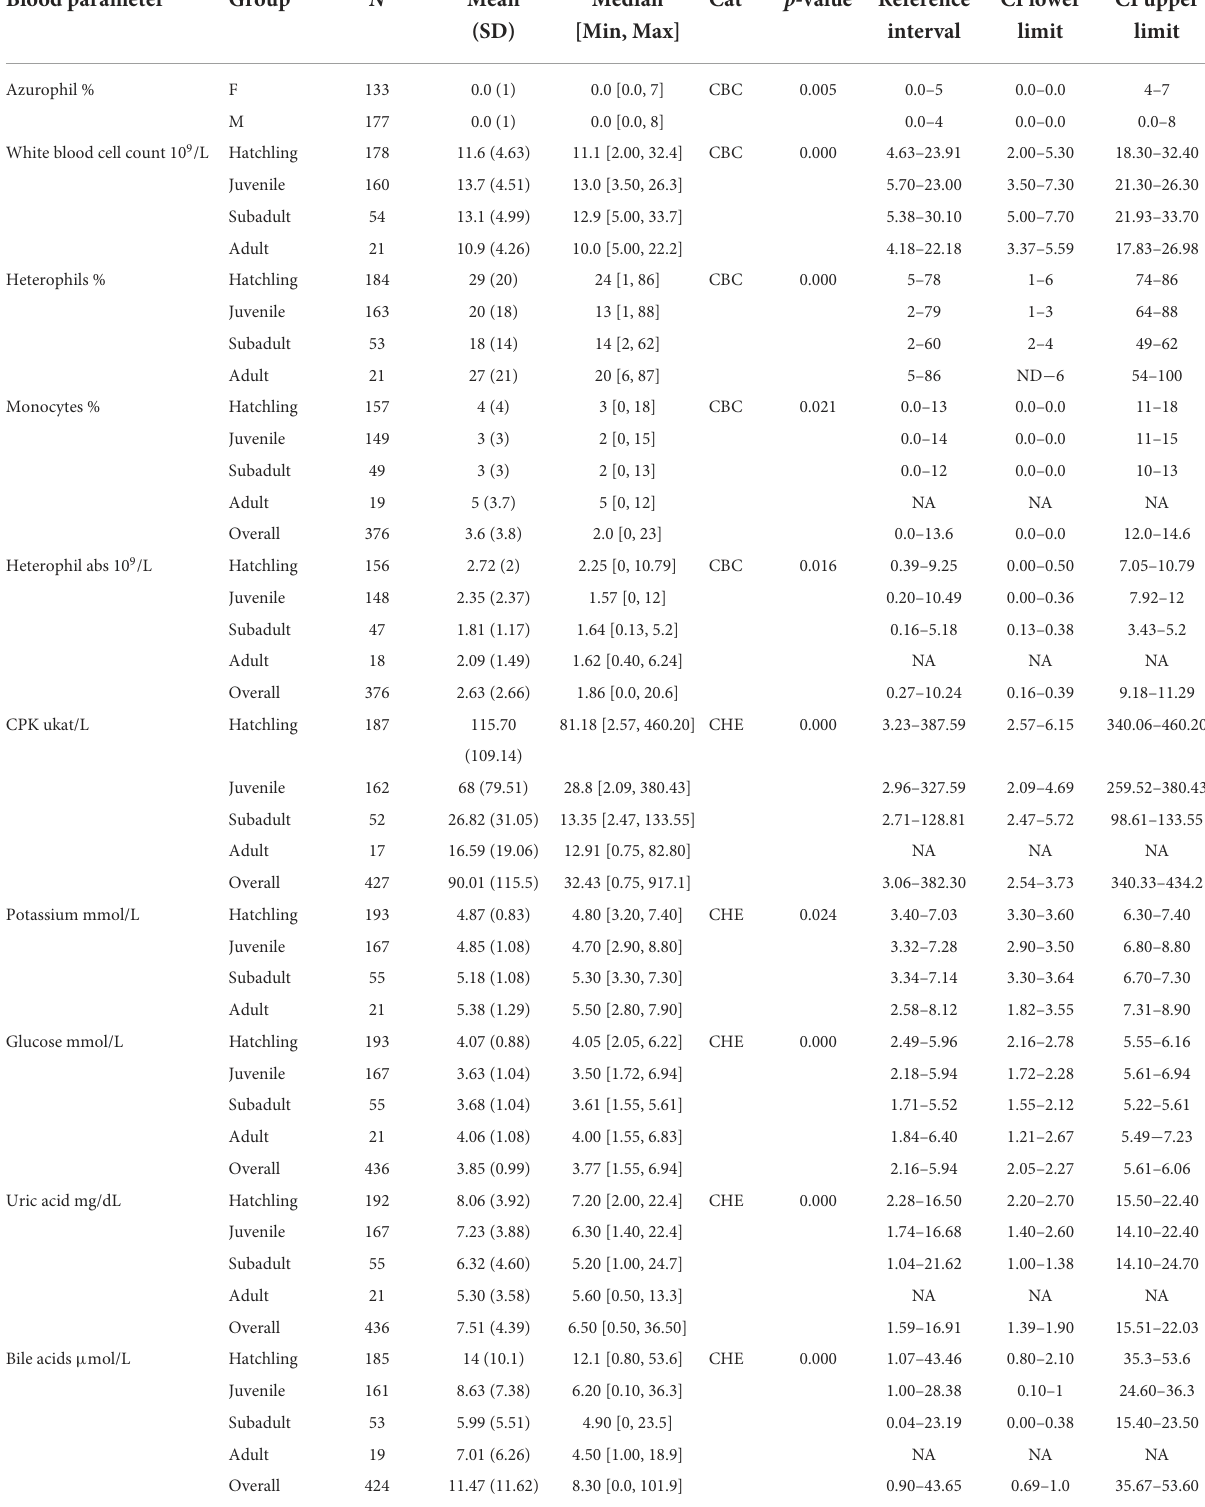
TABLE 3 Hematological and biochemical general statistics and reference values with 90% confidence intervals (CI) for wild American crocodile ( Crocodylus acutus ) analytes that showed statistical evidence of being affected either by sex or by size class in South Florida, United States. Blood